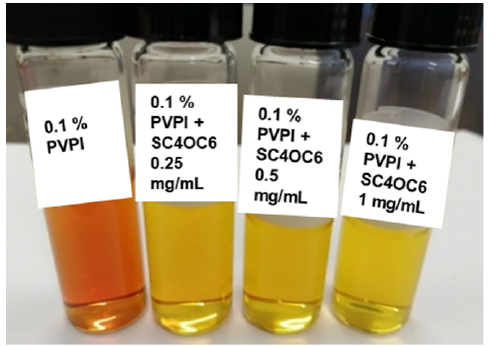
Figure 3. Pictures of 0.1% PVPI solutions alone and with different amounts of SC4OC6 (0.25, 0.5, and 1 mg/mL) in PCB.